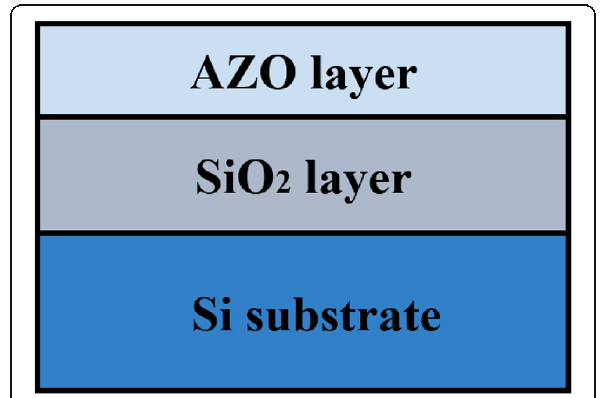
Fig. 4 Surface roughness of nanolaminates with different bilayer thicknesses